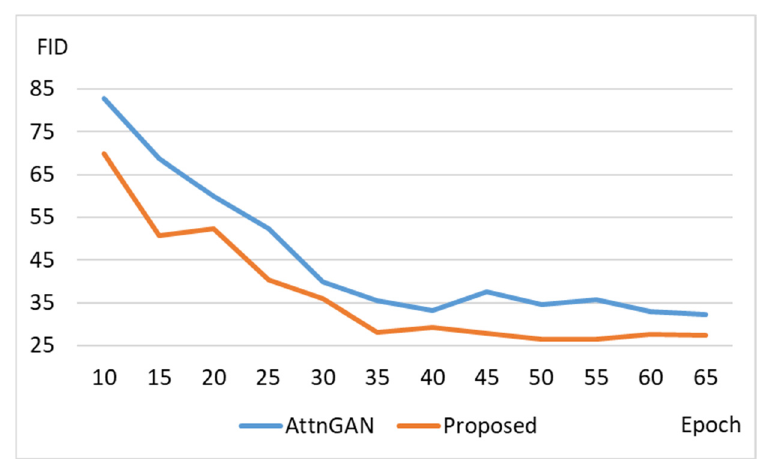
Figure 4. Comparisons on Fréchet Inception Distance.